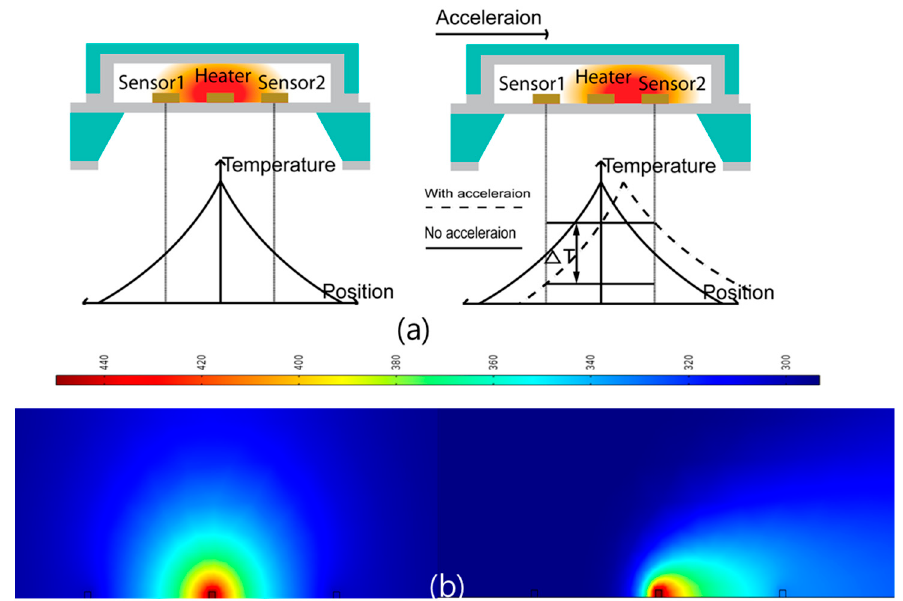
Figure 2. The proposed convective sensor ( a ) basic principle and ( b ) simulation analysis (1 g at 450 K and atmospheric pressure).